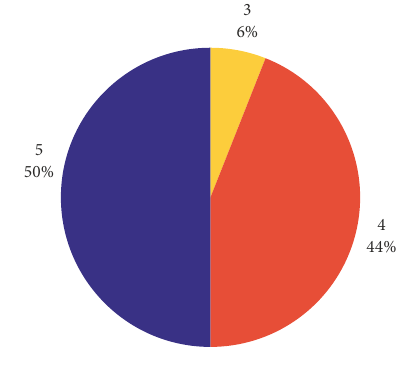
Figure 2. Satisfaction with the delivery time in Bristol: Figure 3. Satisfaction with the timeliness in Bristol: